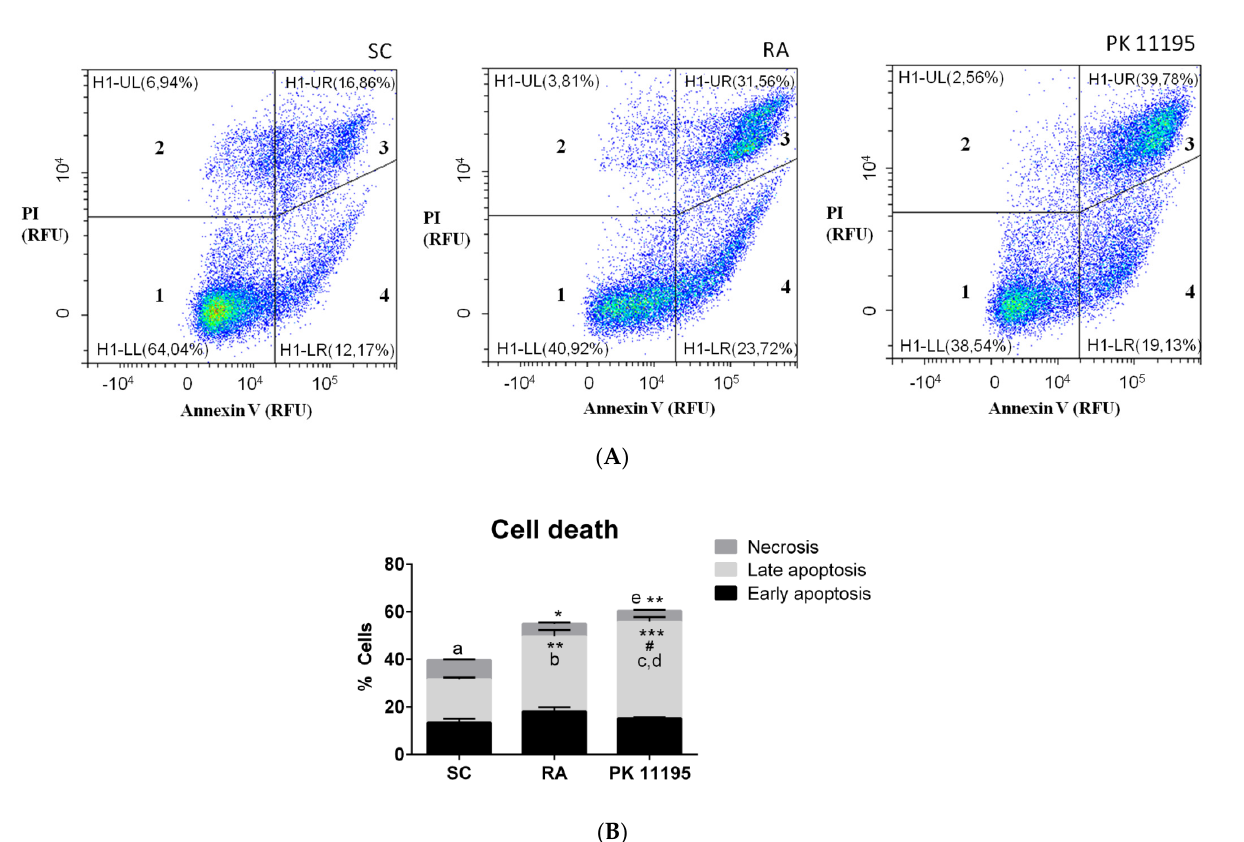
Figure 5. Cell death types in undifferentiated P19 stem cells (SC) and cells treated with 1 μ M retinoid acid (RA) or 50 μ M PK 11195 (PK 11195) during 4 days of treatment. ( A ) Cell death was analyzed by flow cytometry using propidium iodide (PI) together with Annexin V. Representative histograms show relative units of fluorescence (RFU) of PI and/or Annexin V for each one of the experimental conditions (SC, RA, and PK 11195). 1= Live cells; 2= Necrotic cells; 3= Late apoptotic cells; 4= Early apoptotic cells. ( B ) Bar chart shows means ± SEM from the percentage of necrotic, early apoptotic and late apoptotic cells from three independent cell cultures and treatments. * p < 0.05 versus SC; ** p < 0.01 versus SC. *** p < 0.001 versus SC; # p < 0.05 versus RA; a p < 0.05 Necrosis versus late apoptosis in SC; b p < 0.05 Late apoptosis versus necrosis and early apoptosis in RA; c p < 0.05 Late apoptosis versus early apoptosis in PK 11195; d p < 0.01 Late apoptosis versus necrosis in PK 11195; e p < 0.05 Necrosis versus early apoptosis in PK 11195.